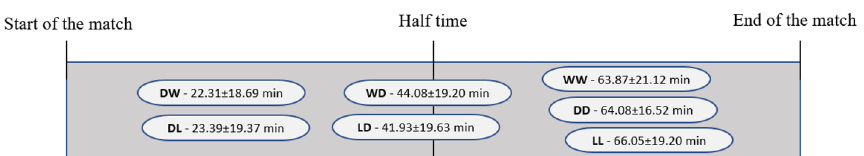
Figure 3. Average minute of the match, when each of the phases occurred (mean ± SD). DW (Drawing to Winning); LD (Losing to Drawing); WW (Winning to Winning); DD (Drawing to Drawing); LL (Losing to Losing); DL (Drawing to Losing); WD (Winning to